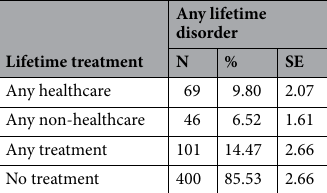
Table 4. Proportional treatment among youth who received lifetime treatment for DSM-IV/CIDI disorders. Part II Sample was used (n = 971); any disorder (n =